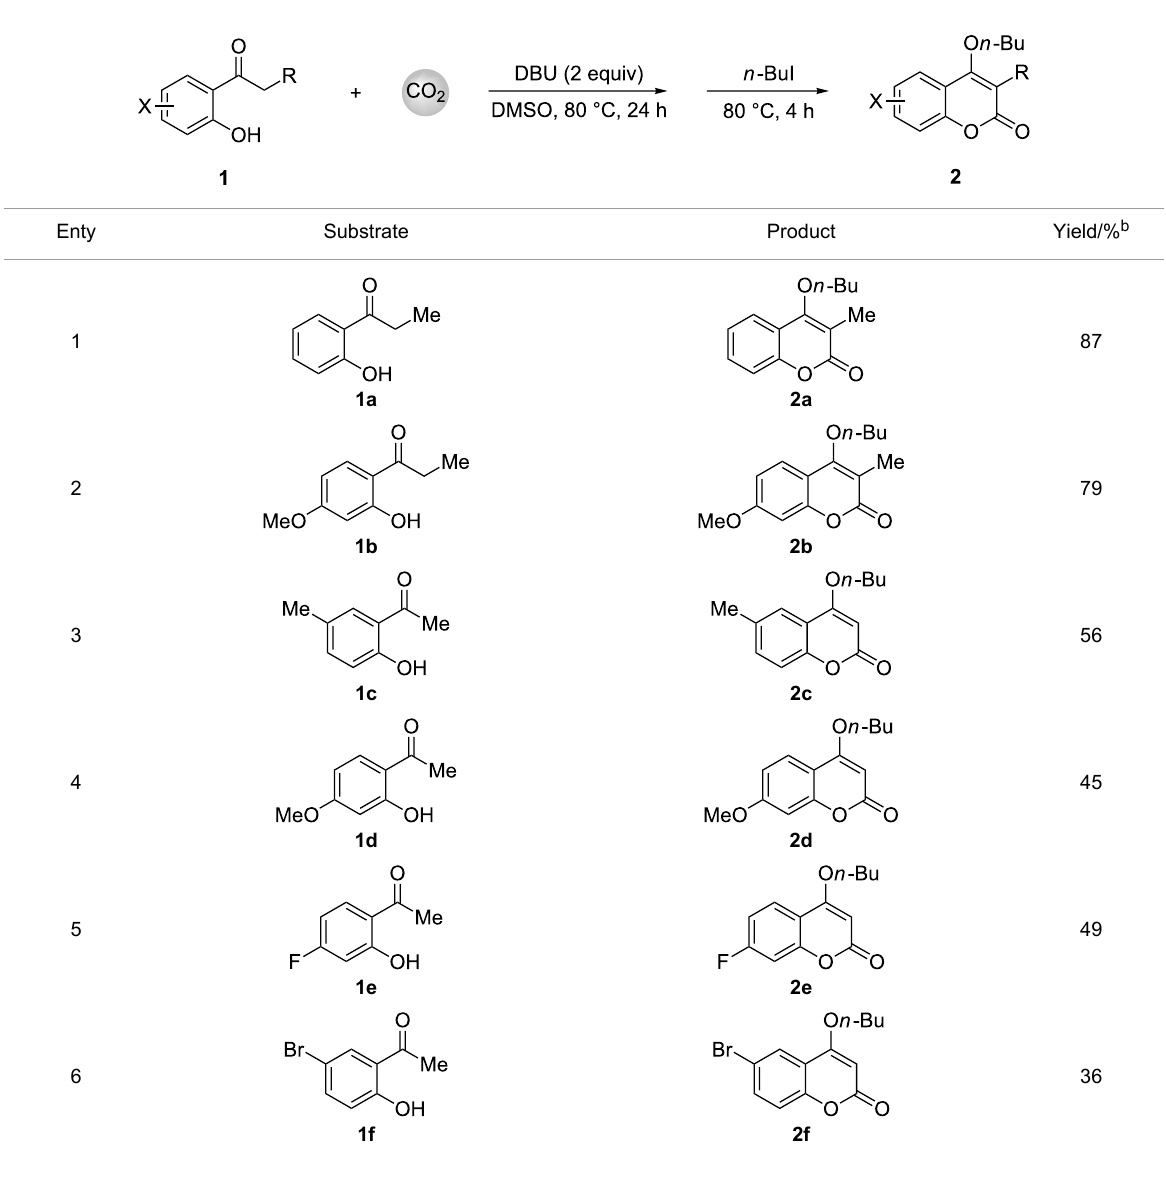
Table 2: Carboxylative cyclization of various o -hydroxyacetophenones with carbon dioxide. a